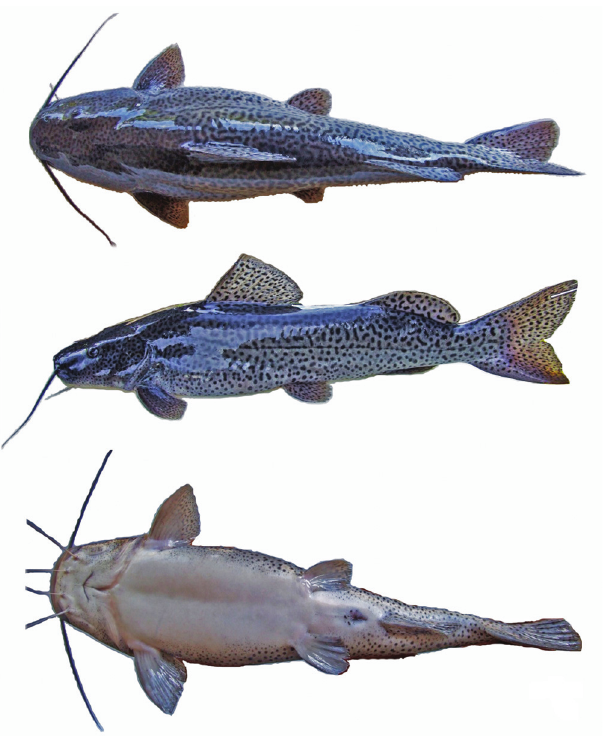
Fig. 1. Dorsal, lateral and ventral views of Steindachneridion parahybae . Broodstock female, 520 mm total length, Paraíba do Sul River basin, Paraibuna, São Paulo State,